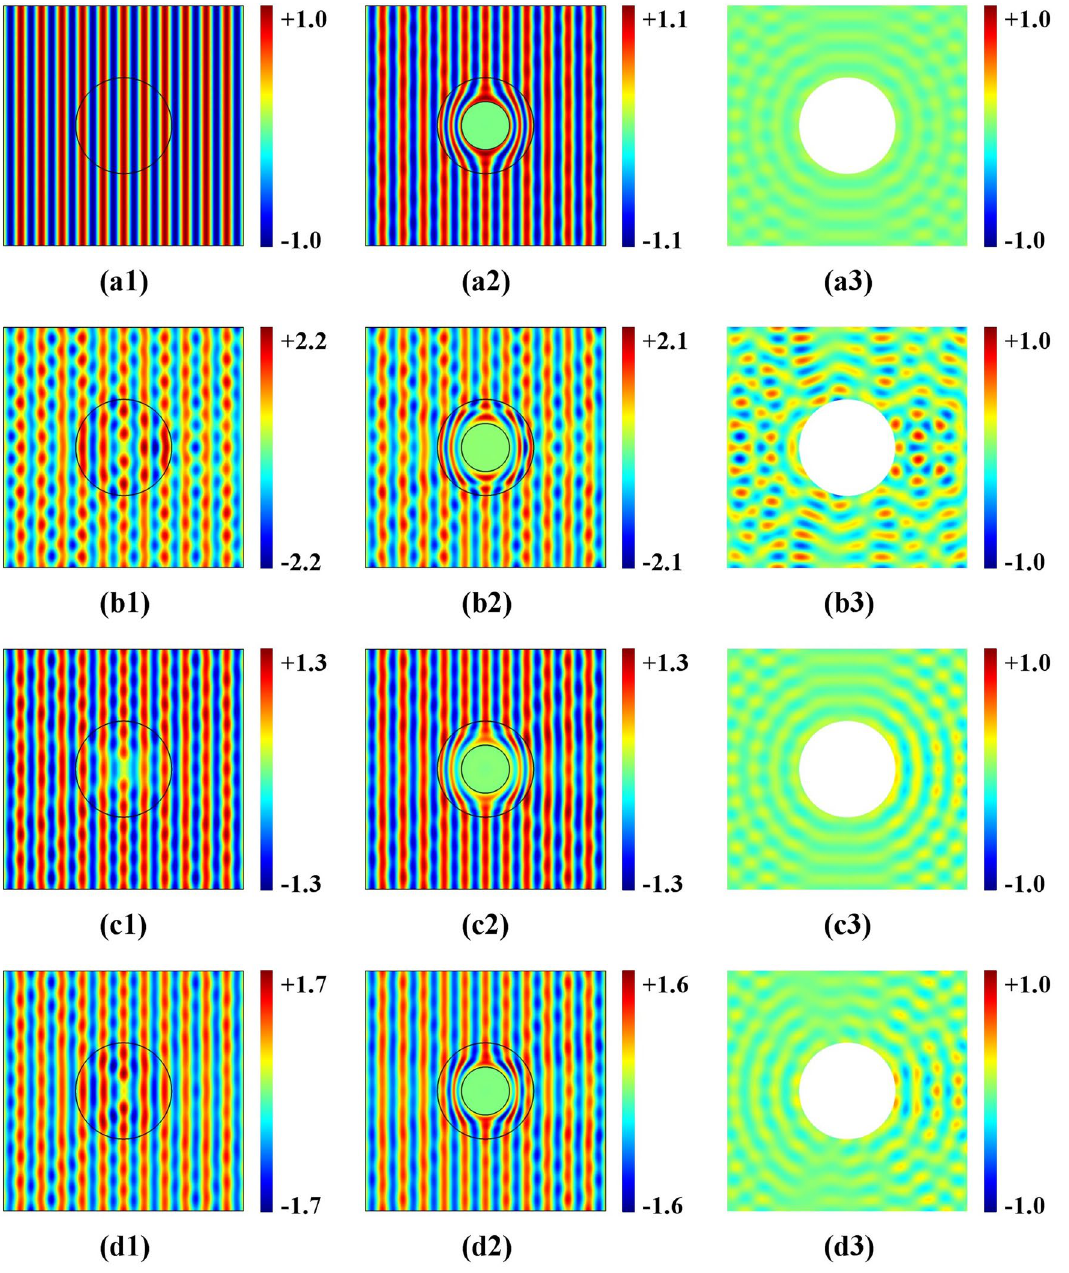
Figure 2. (color online) Acoustic-wave pressure distribution and scattered acoustic-wave pressure distribution using the cloak design for the four cases of different impedance function settings in the original space. ( a ) impedance function k ( d ) impedance function k